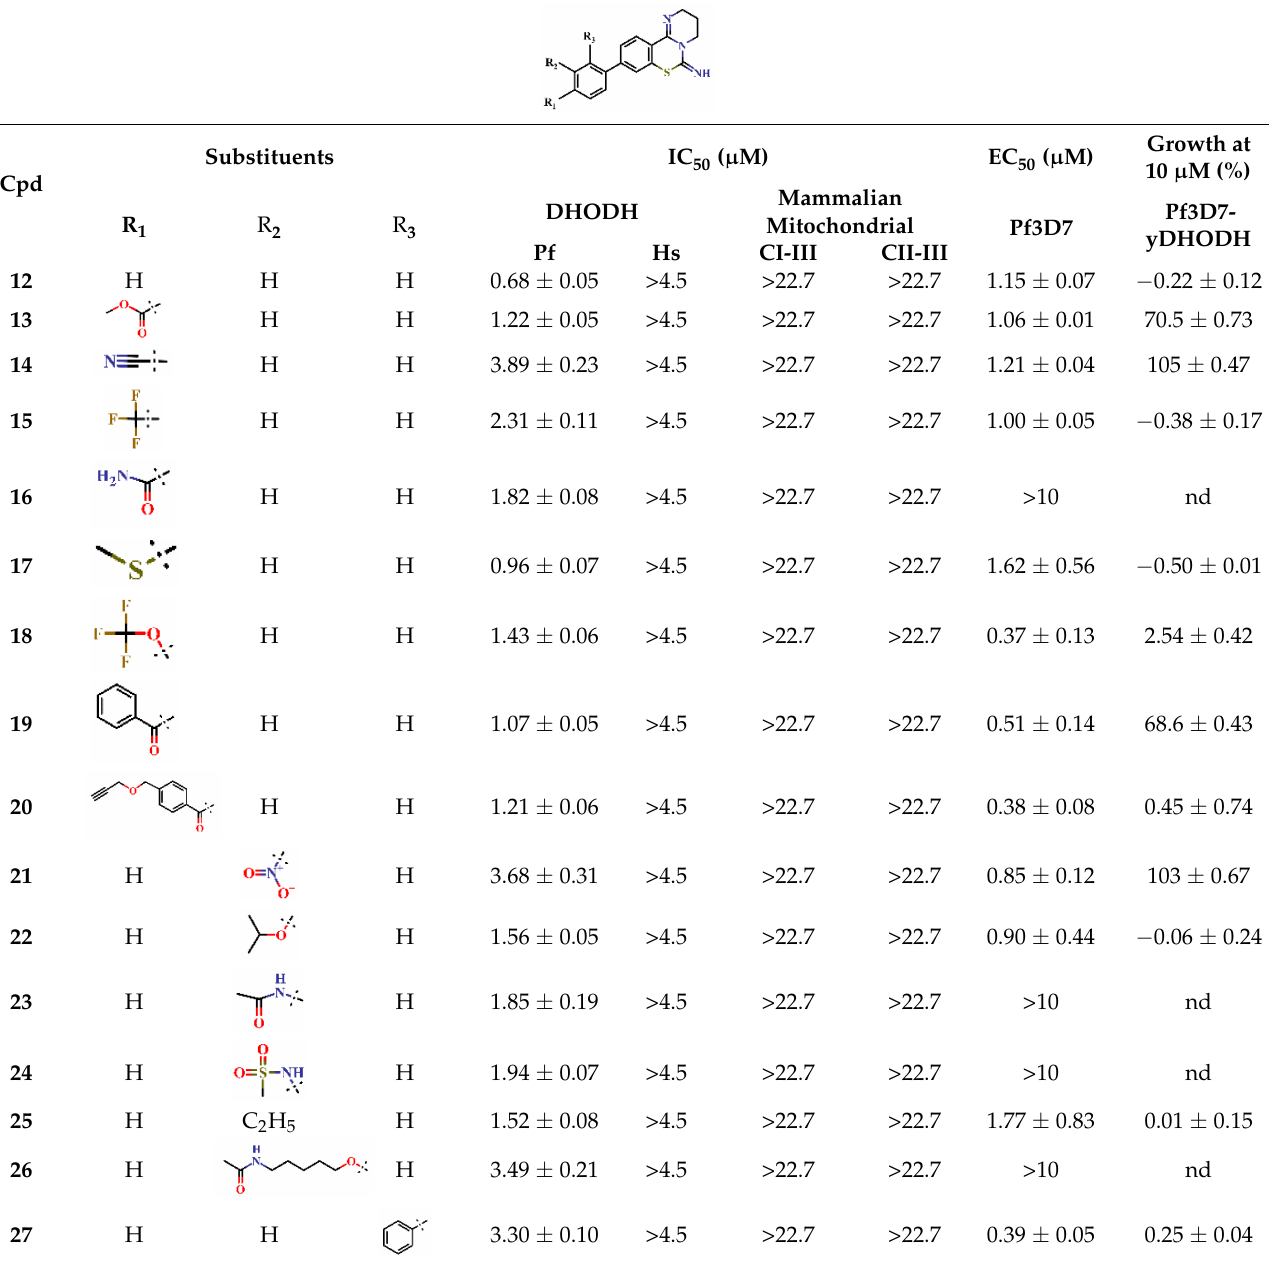
Table 2. Antimalarial activities of Compound 12 derivatives.